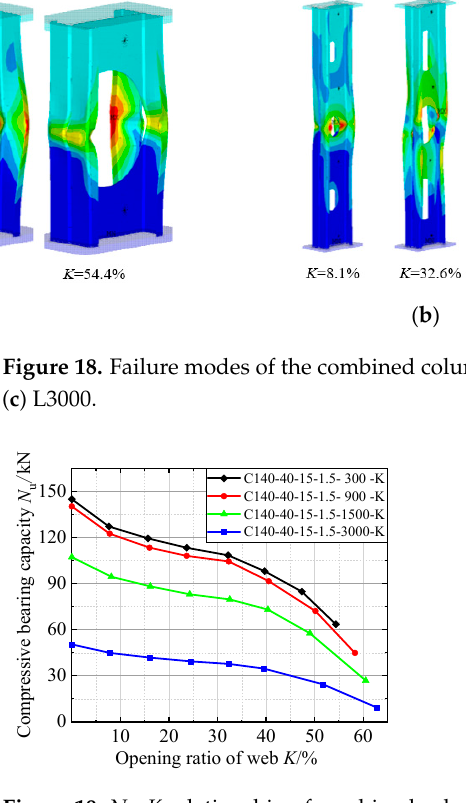
Figure 19. N u - K relationship of combined columns.